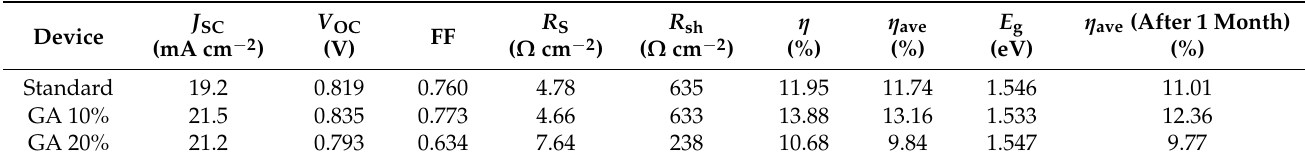
Table 1. Measured photovoltaic parameters of solar